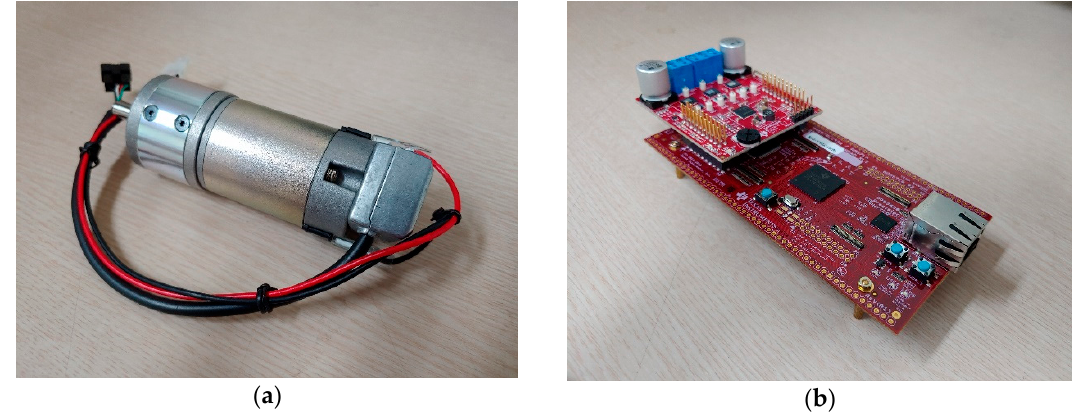
Figure 6. Target motor and controller: ( a ) motor, ( b ) controller.